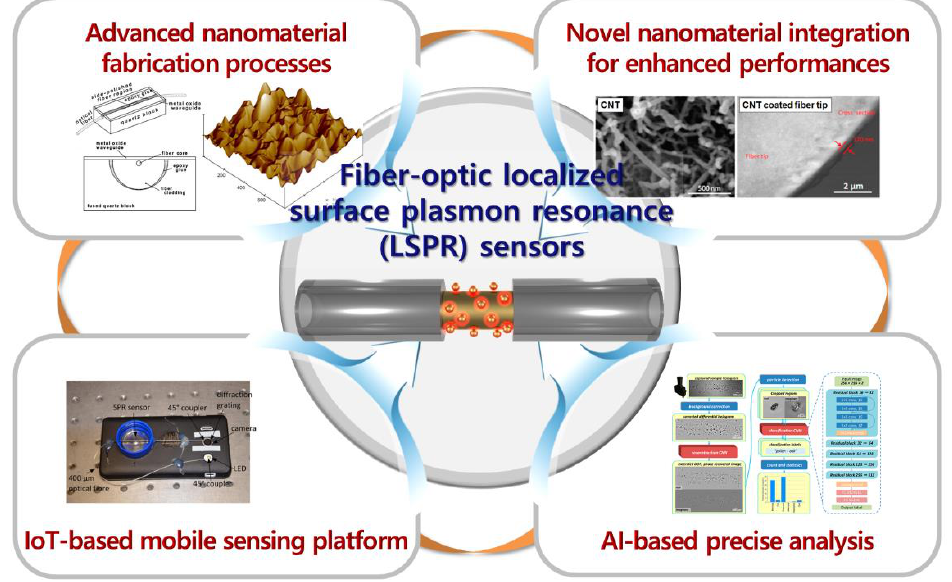
Figure 14. Technologies to enhance the performance of fiber-optic LSPR sensors through further developments and applications. (1) Advanced nanomaterial fabrication processes to ensure uniformity of the plasmonic nanomaterials. (2) Integration of novel nanomaterials to enhance the sensing performance. (3) Application of communication/IoT techniques to produce mobile sensing platforms. (4) Precise analysis by machine learning and AI. The reuse of the inset figures representing each technology was permitted by Elsevier ([118]), Molecular Diversity Preservation International ([119]), Optical Society of America ([120]), and American Chemical Society ([121]).